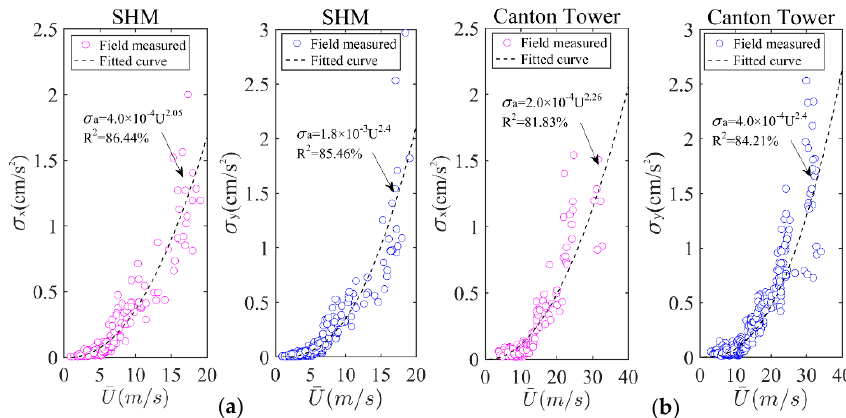
Figure 7. Correlation between mean wind speed measured at two sites and the standard deviation of acceleration response at 56/F of Leatop Plaza. ( a ) SHM; ( b ) Canton Tower.